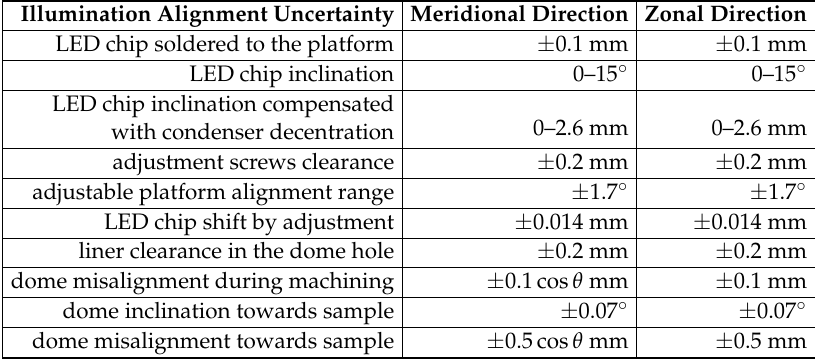
Table A1. The uncertainty specification of illumination source